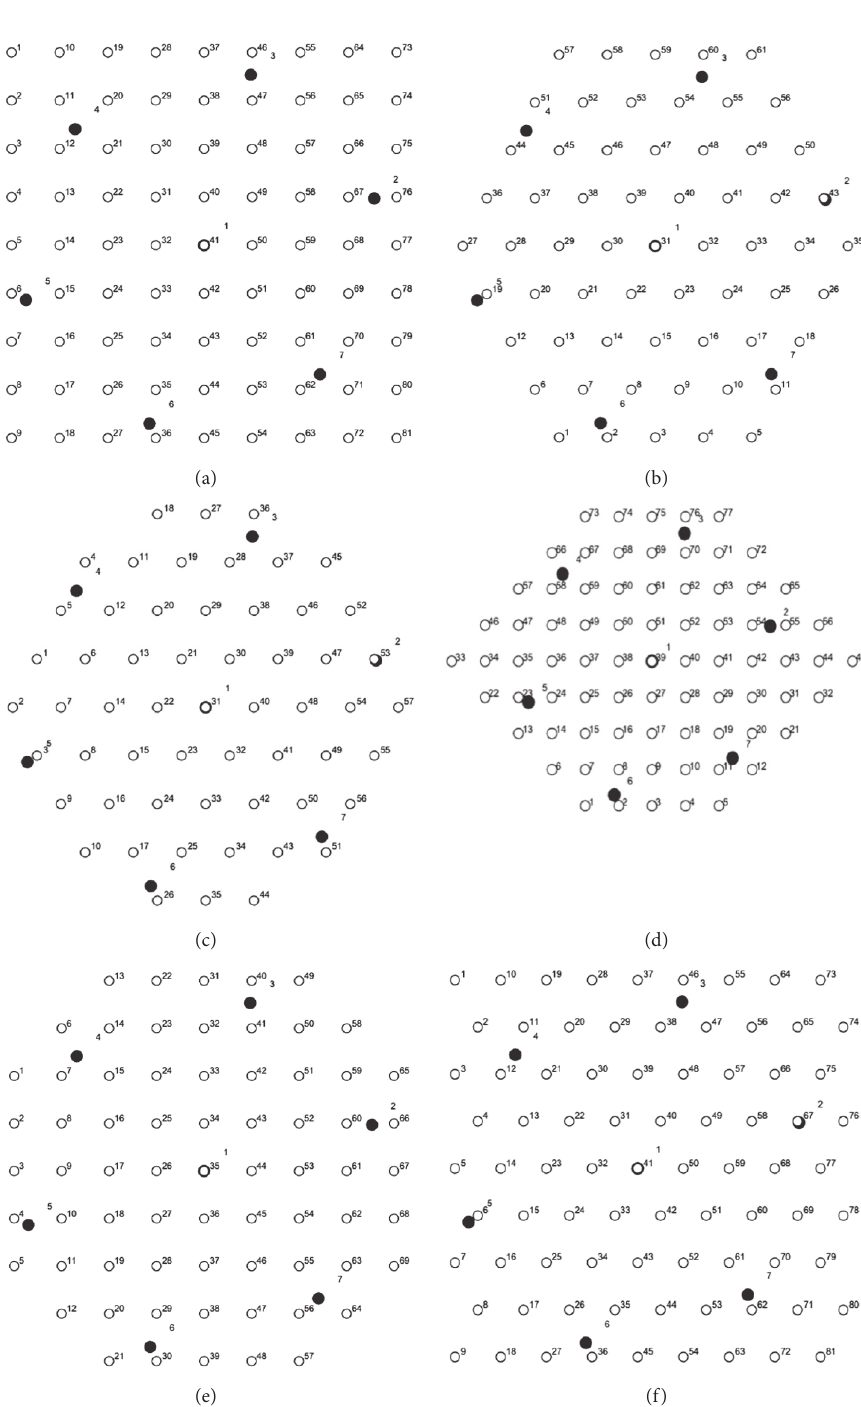
Figure 15: Six planar arrays; black dots are the 7-element NSA (see the text for more